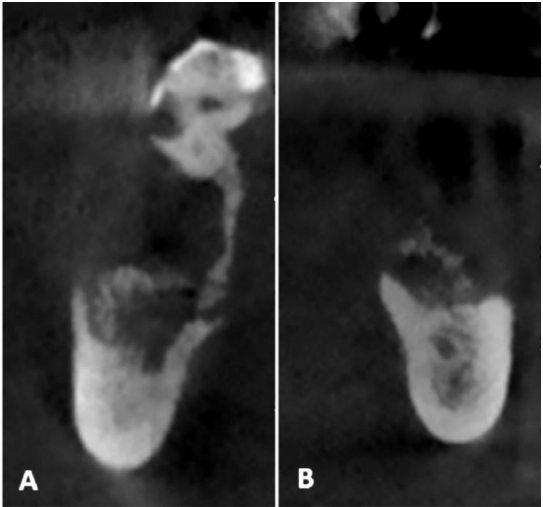
Figure 3. The presence of altered bone morphology on the preoperative CBCT ( A , B ), with the involvement of the right-sided mandibular canal with loss of root continuity ( A ).